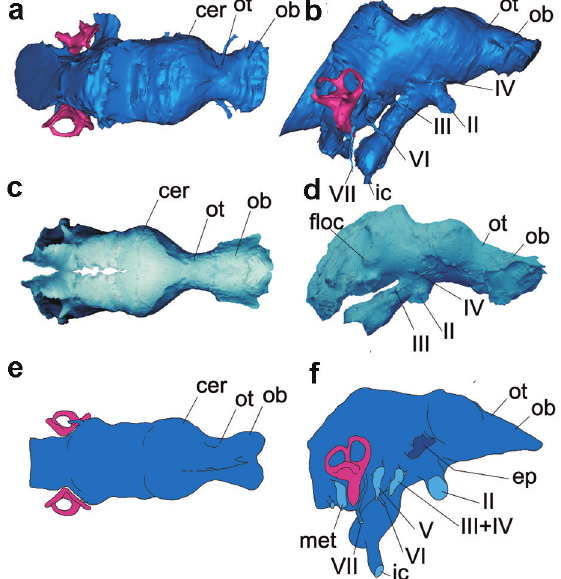
Figure 4. Endocranial casts of Limaysaurus (a, b), rebbachisaurid MMCh-PV 71 (c, d), and Nigersaurus (e, f) compared; in dorsal (left column) and right lateral (right column) views. Abbreviations: cer, cerebral hemisphere; ep, epiotic fenestra; floc, flocculus of cerebellum; ic, cerebral branch of internal carotid artery; met, metotic passage; ob, olfactory bulb; ot, olfactory tract; I-XI, cranial nerves. (c, d, modified from Paulina-Carabajal et al 2014; e, f, modified from Sereno et al. 2007). Not to